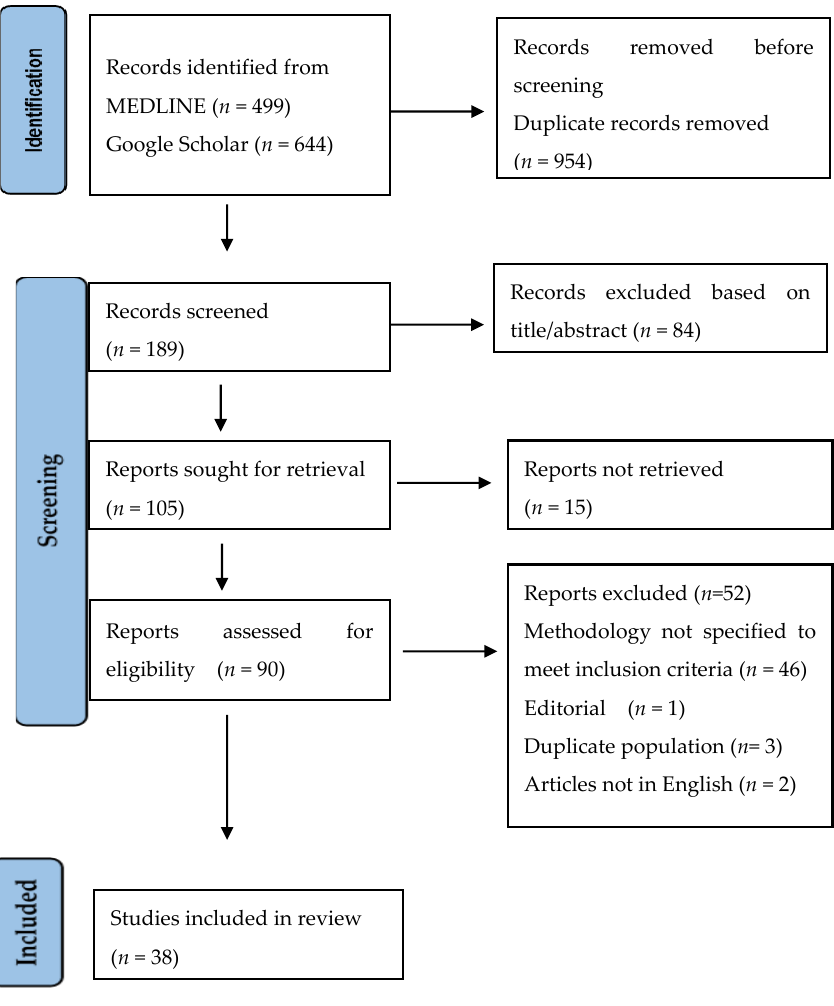
Figure 1. PRISMA flow